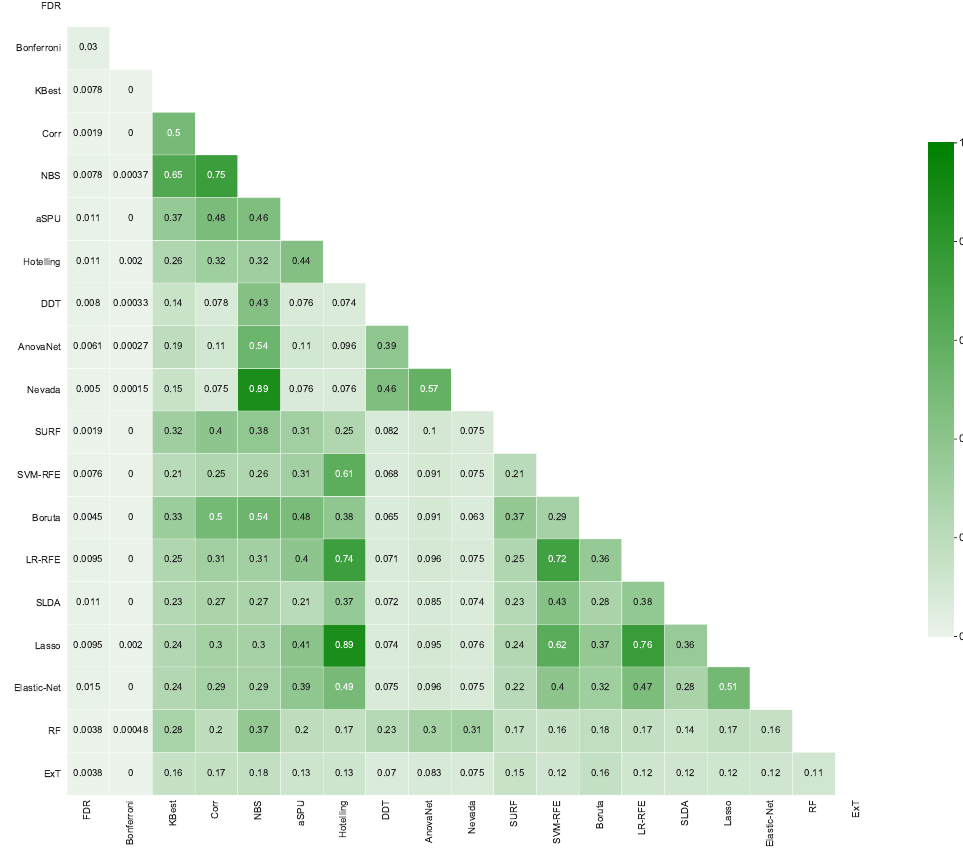
Figure 6. Inter-stability of each pairs of methods, i.e., fraction of common links they both yield, measured according to Equation